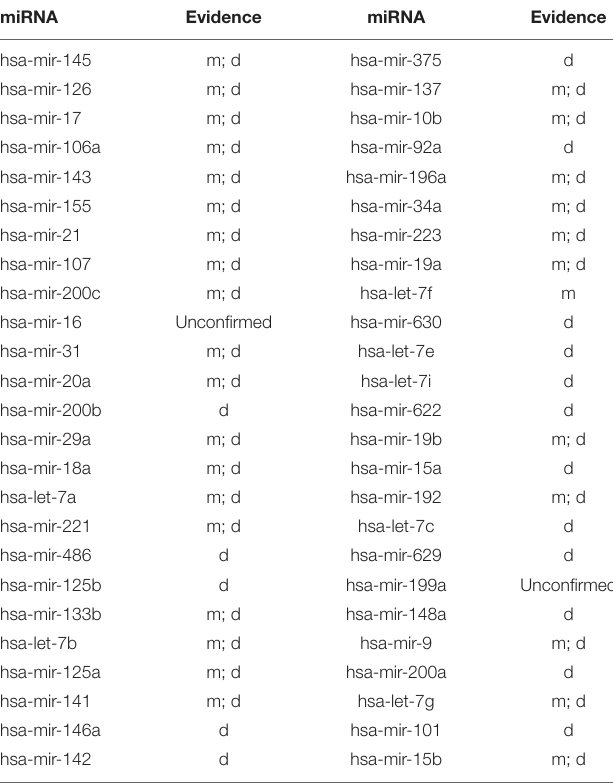
TABLE 2 | The top 50 potential miRNAs associated with colon